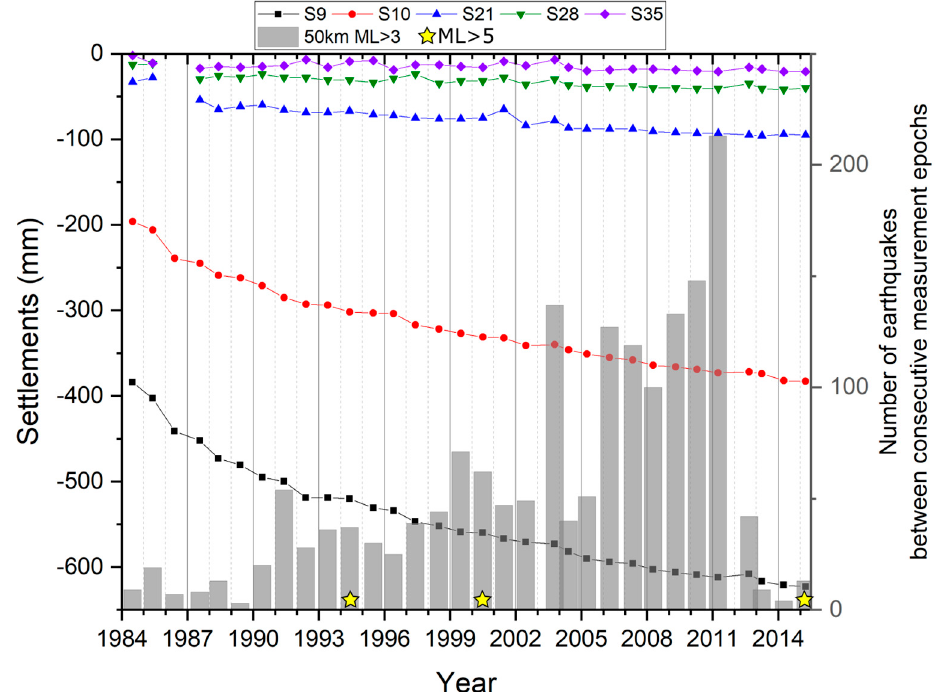
Figure 9. Settlements and occurrence of earthquakes (M L > 3) within a radius of 50 km from the dam site between consecutive measurement epochs. Stars indicate the largest earthquakes during the examined period (M L 5.4 in 1993, M L 5.3 in 2000, and M L 5.2 in 2014 at distances of 36.8 km, 15.4 km, and 16.3 km from the dam, respectively). Earthquake data were sourced from the National Observatory of Athens.